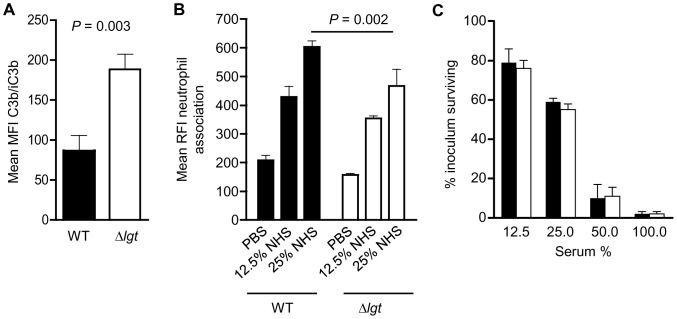
Effects of the Δlgt mutation on interactions with neutrophils.(A) C3b/iC3b deposition on the wild-type and Δlgt strains after incubation in 20% serum as measured by geometric mean fluorescent intensity using a flow cytometry assay. (B) Neutrophil association of the wild-type and Δlgt strains after incubation in 20% serum and human neutrophils as measured by mean relative fluorescent intensity using a flow cytometry assay. (C) Neutrophil killing assays of the wild-type (black columns) and Δlgt strains (clear columns) after incubation in different concentrations of human serum with fresh human neutrophils (MOI 1 bacteria to 800 neutrophils). There were no statistically significant differences between the wild-type and Δlgt strains. Data are presented as the percentage of the inoculum surviving after 30 mins incubation. For all panels, data are for mean values with error bars representing SDs. Statistical comparisons were made using unpaired two tailed T tests, and P values inserted for selected data showing significant differences.